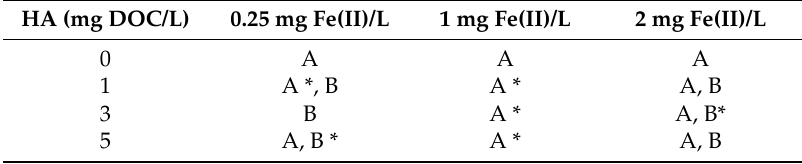
Table 3. Experimental conditions used for the experiments shown in Figures 4, 6, 7, and 10.